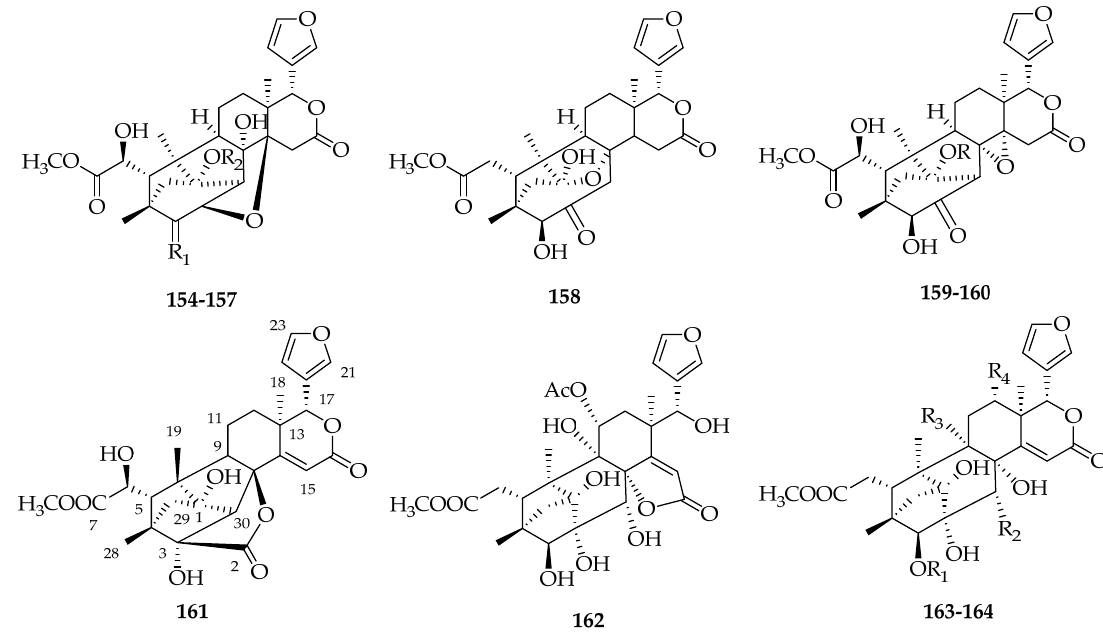
Figure 6. Chemical structures of polyoxyphragmalin ‐ type limonoids 154 – 164 . Table 5. Structures and sources of polyoxyphragmalin ‐ type limonoids 154 – 164 .